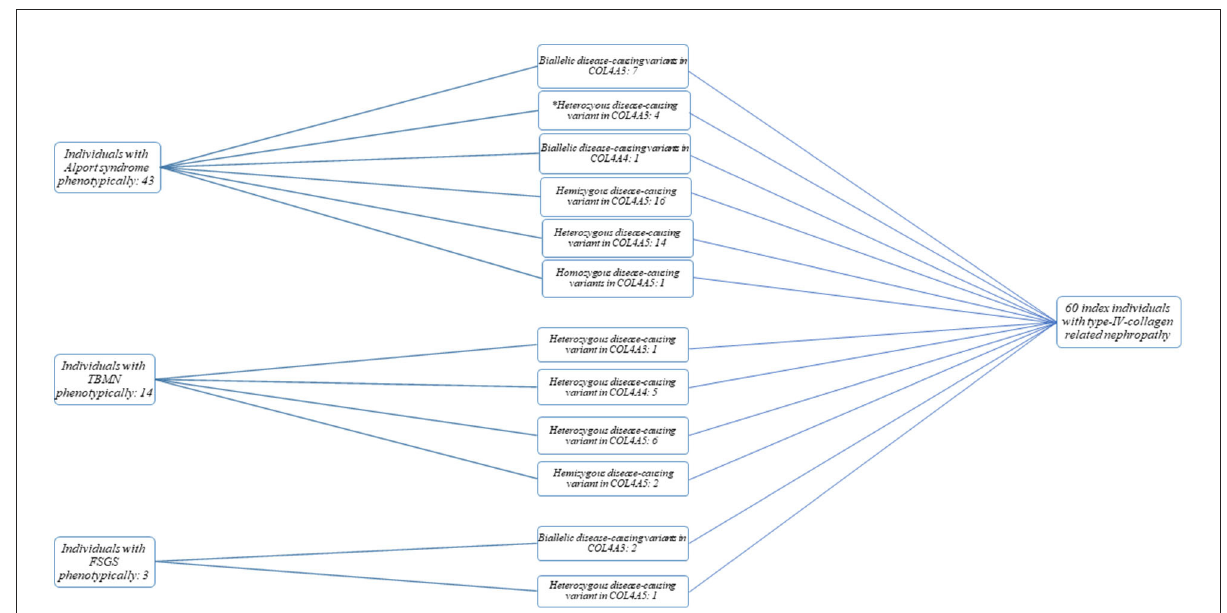
FIGURE1 Flow chart and cohort overview. Categorization of individuals into Alport syndrome (AS), thin basement membrane nephropathy (TBMN), and focal segmental glomerulosclerosis (FSGS) phenotypic subgroups was based on clinical tentative diagnosis/kidney biopsy result. *, Individuals with a questionable